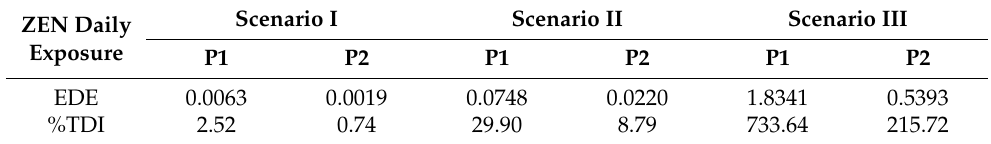
Table 4. The estimated daily exposure to ZEN ( µ g/kg bw/day) and %TDI in three exposure